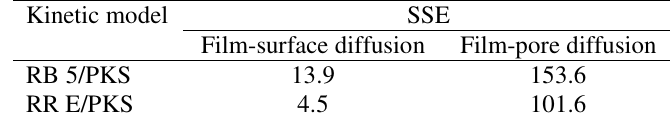
Table 5. Comparison of SSE of film-surface diffusion and film-pore diffusion models for adsorption of RB 5and RR E onto PKS